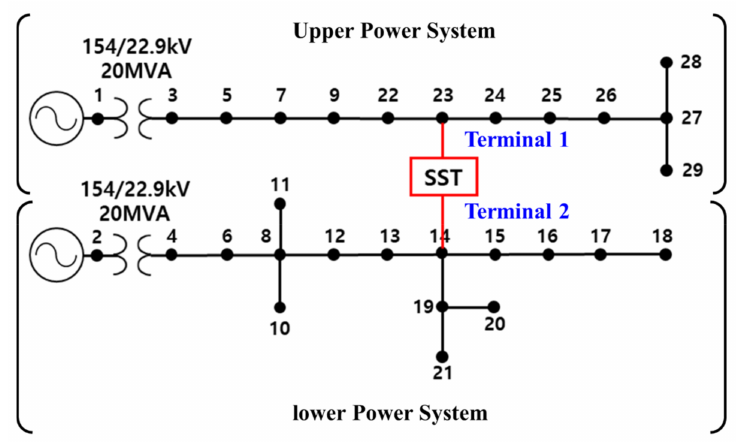
Figure 4. Diagram of an